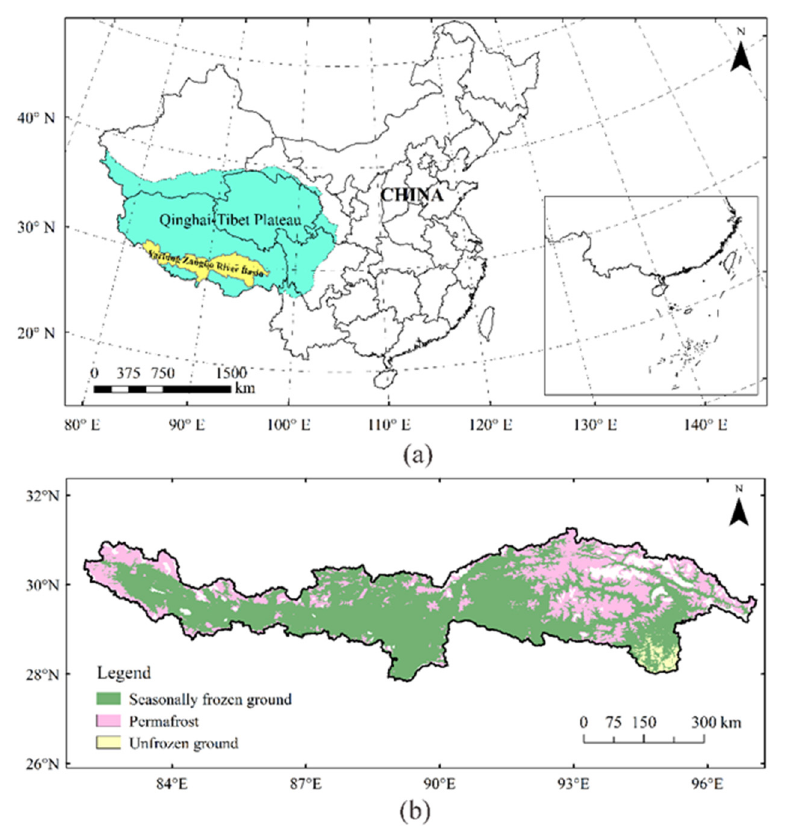
Figure 1. Location of the Yarlung Zangbo River Basin (YZRB) ( a ) and distribution of permafrost in the YZRB ( b ) obtained from the National Tibetan Plateau Data Center (http://data.tpdc.ac.cn/zh-hans/, accessed on 12 January 2020), which was based on the new map of permafrost distribution on the Qinghai–Tibet Plateau (QTP) (Zou, Zhao, and Sheng, 2017) [38].